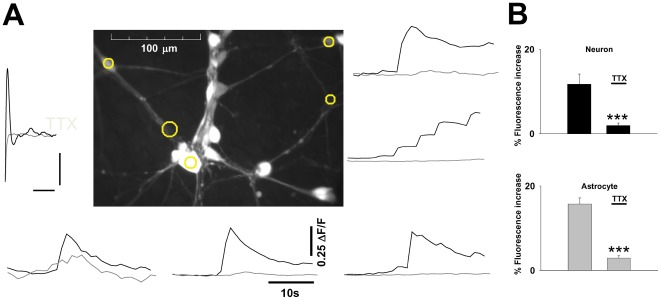
NT2 neurons support network activity.
A. Centre image shows neuronal cell bodies and processes. Plots of fluorescence over time from the circled areas are displayed to the right and below. Black traces illustrate response to electrical stimulation in control conditions and grey traces following TTX application. B. Bargraphs summarise calcium elevation responses of neurons and astrocytes for a number of experiments. Scale bar in A, 5 mV, 2 ms. Cells were used within 14 days of differentiation.